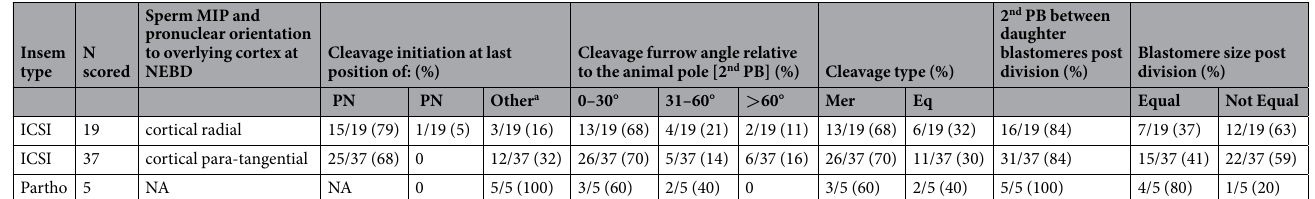
Table 2. NHP Zygote Cleavage Patterns in Relation to Pronuclear Cortical Orientation and the Zygotic A → V Axis Analyzed from TLVM Recordings. Insem: insemination; Mer: meridional cleavage; Eq: equatorial cleavage; NEBD: pronuclear envelop breakdown; Partho: parthenogenetic chemical activation by ionomycin/6-DMAP exposure; no sperm DNA contribution; NA: not applicable. a includes random cortical and/or 2 nd PB